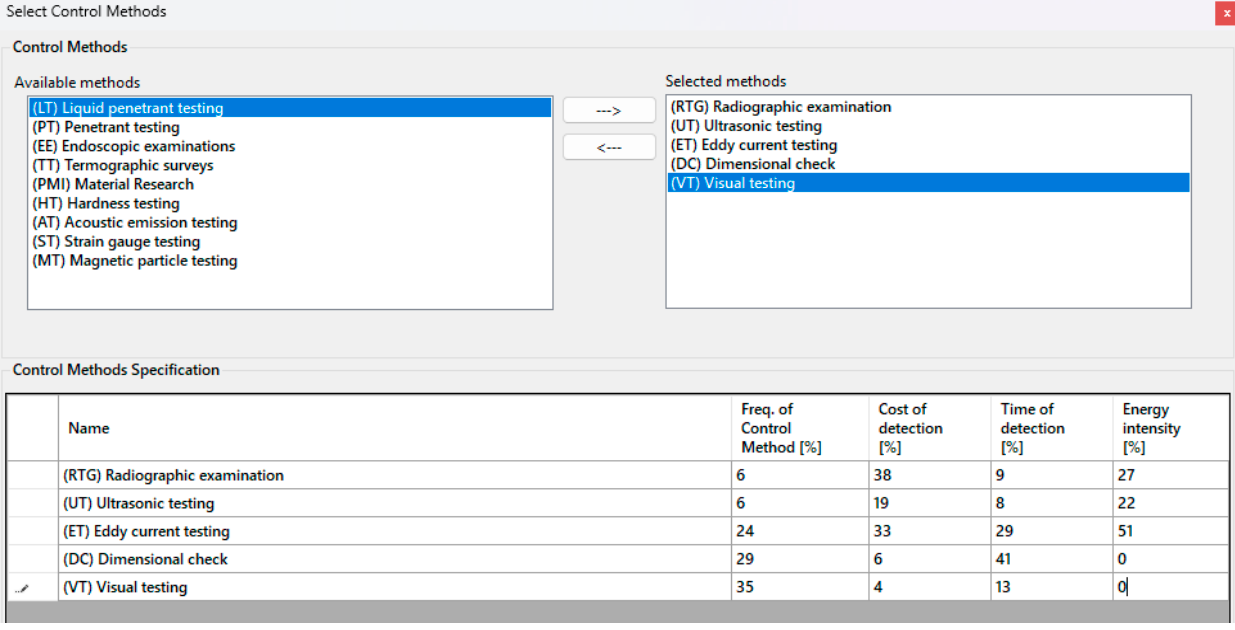
Figure 4. Define the basic parameters that characterise the detection methods implemented as part of the process.